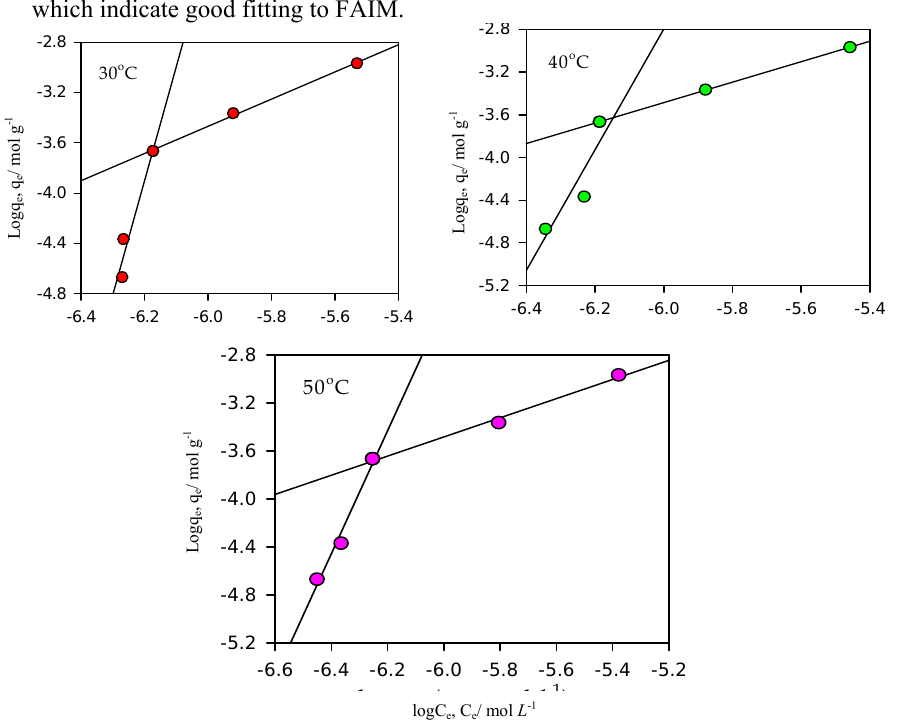
Figure 7 . FAIM for the adsorption of 3-OCH different temperatures